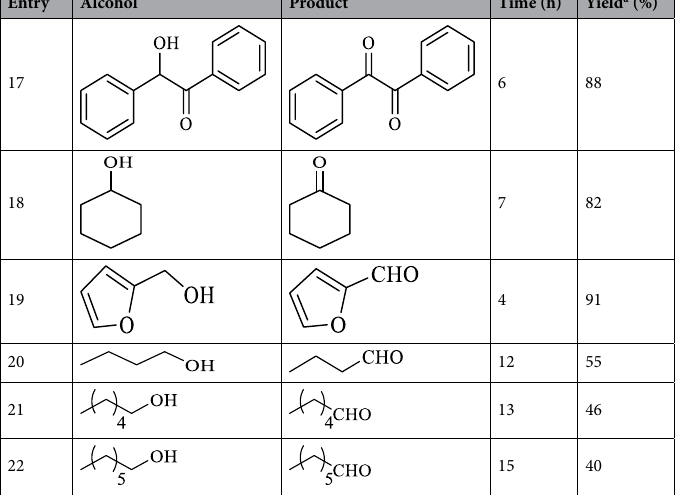
Table 2. Oxidation of alcohols to carbonyl compounds with TBHP catalyzed by (γ-Fe 2 O 3 -Im-Py) 2 WO 4 . a Isolated yield. Reaction conditions: benzyl alcohol (1 mmol), TBHP (6 mmol) and (γ-Fe mg, 2 mol%: based on W content and relative to alcohol) at 90 °C.